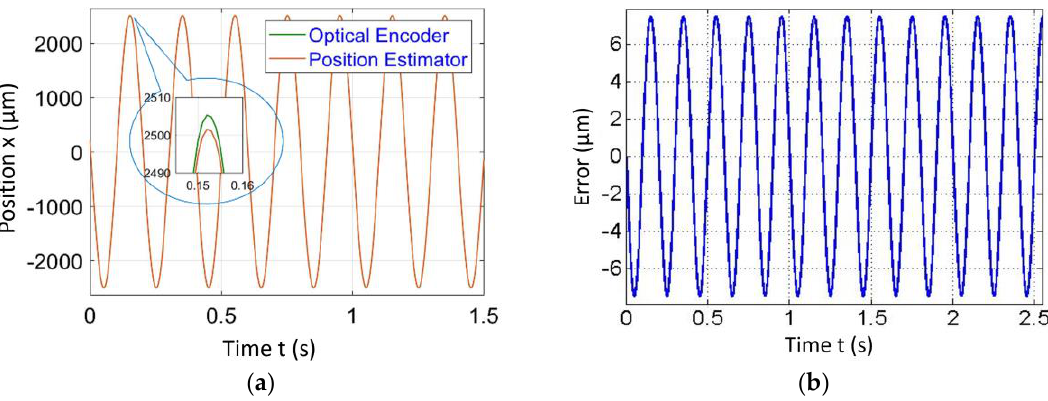
Figure 17. Position estimator output for amplitude = 2500 µm and frequency = 5 Hz at a scanning speed = 50 mm/s.